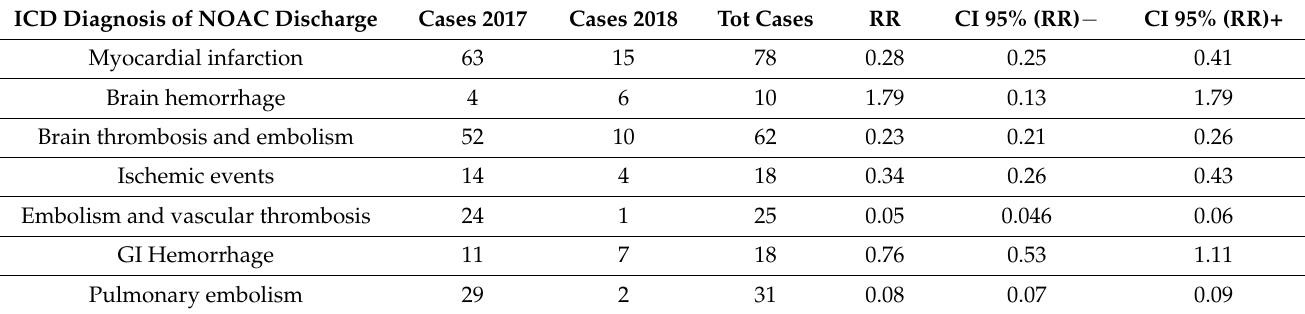
Table 4. RR for major discharge diagnoses analyzed: NOACs.